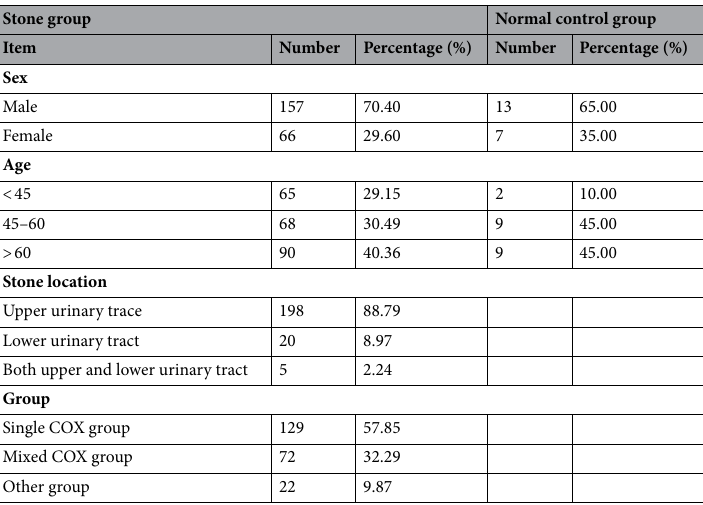
Table 1. Population data. COX calcium oxalate.